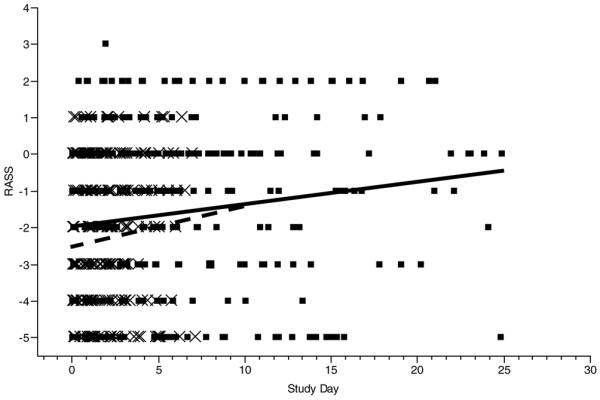
Mixed-model repeated measures comparison of Richmond Agitation-Sedation Scale (RASS) score over the course of mechanical ventilation in patients treated by daily interruption of sedation (solid line) and sedation algorithm (dashed line). The group treated by daily interruption of sedation had higher RASS scores (P = 0.049). Individual measurements are shown (× for sedation algorithm and ▪ for daily interruption of sedation).